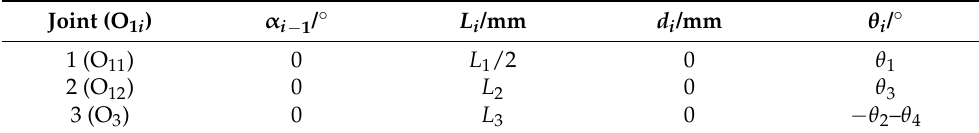
Table 2. Lift branch parameters.